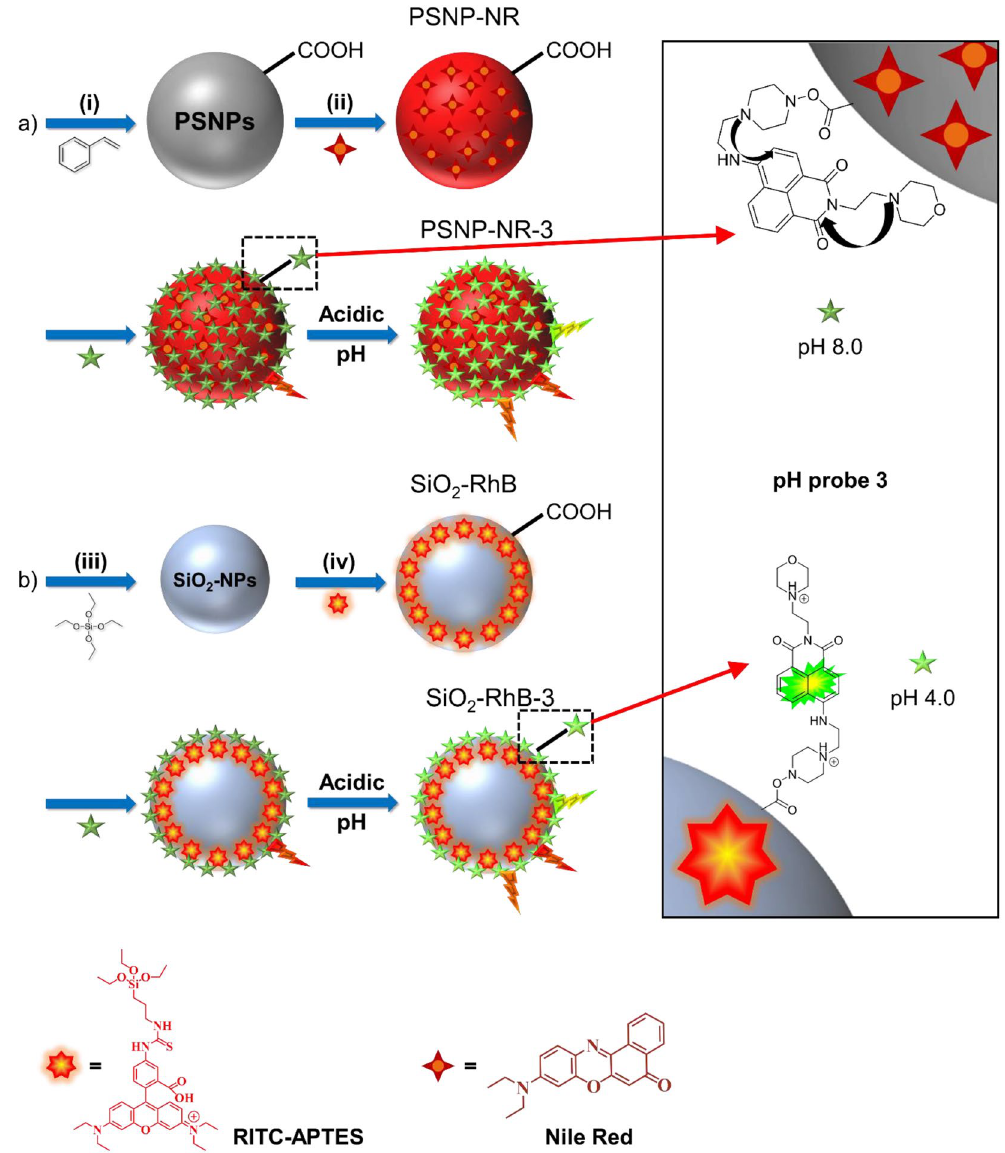
Figure 3. ( a ) Schematic representation of the synthesis of Nile Red (NR) loaded PSNPs, where the pH-inert reference dye is homogeneously distributed within the particle core; (i) synthesis of pristine PSNP-COOH,